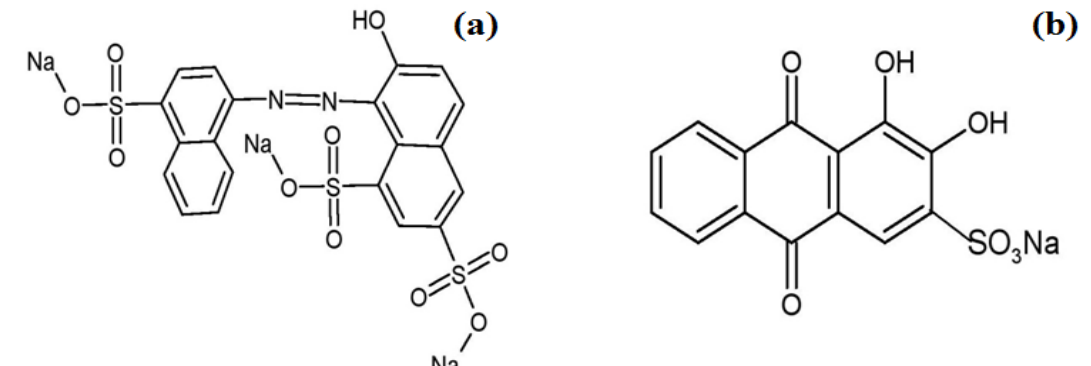
Fig. 1. (a). Molecular structure of Ponceau 4R and (b). Alizarin